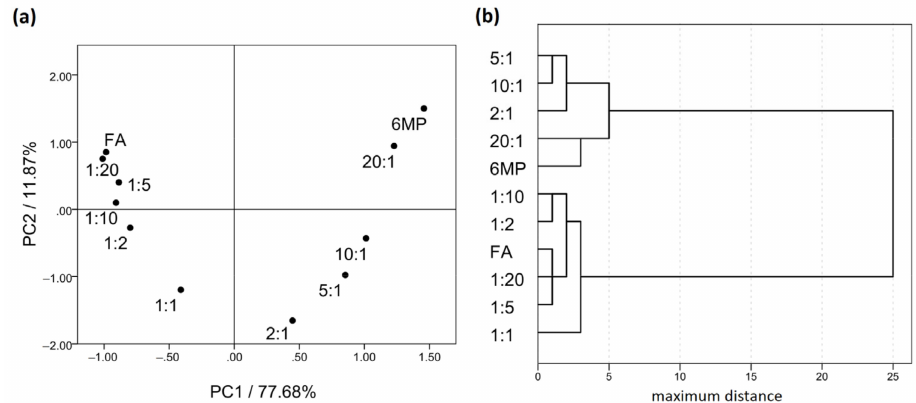
Figure 4. ( a ) Principal component analysis (PCA) scatterplot of 6MP, FA and blends. ( b ) Dendrogram of the cluster analysis (CA) for 6MP, FA and blends. Numbers denote the 6MP:FA mass ratios in the blends.